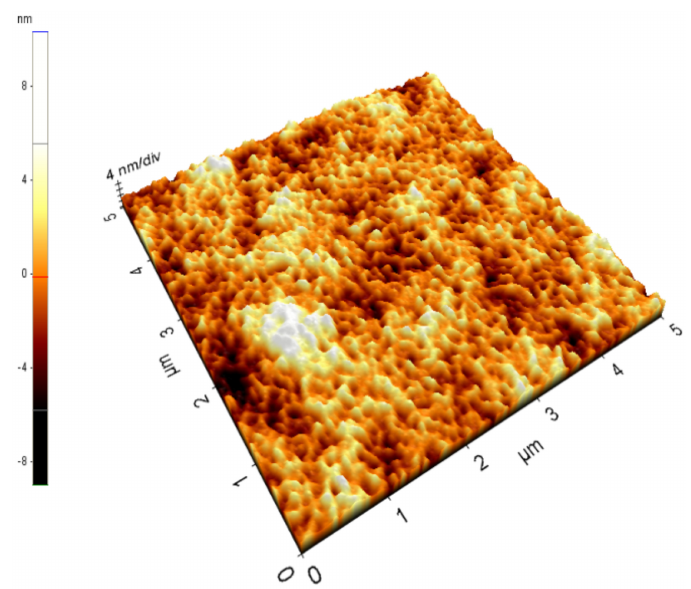
Figure 4. Topography of the DD 87% chitosan membrane.